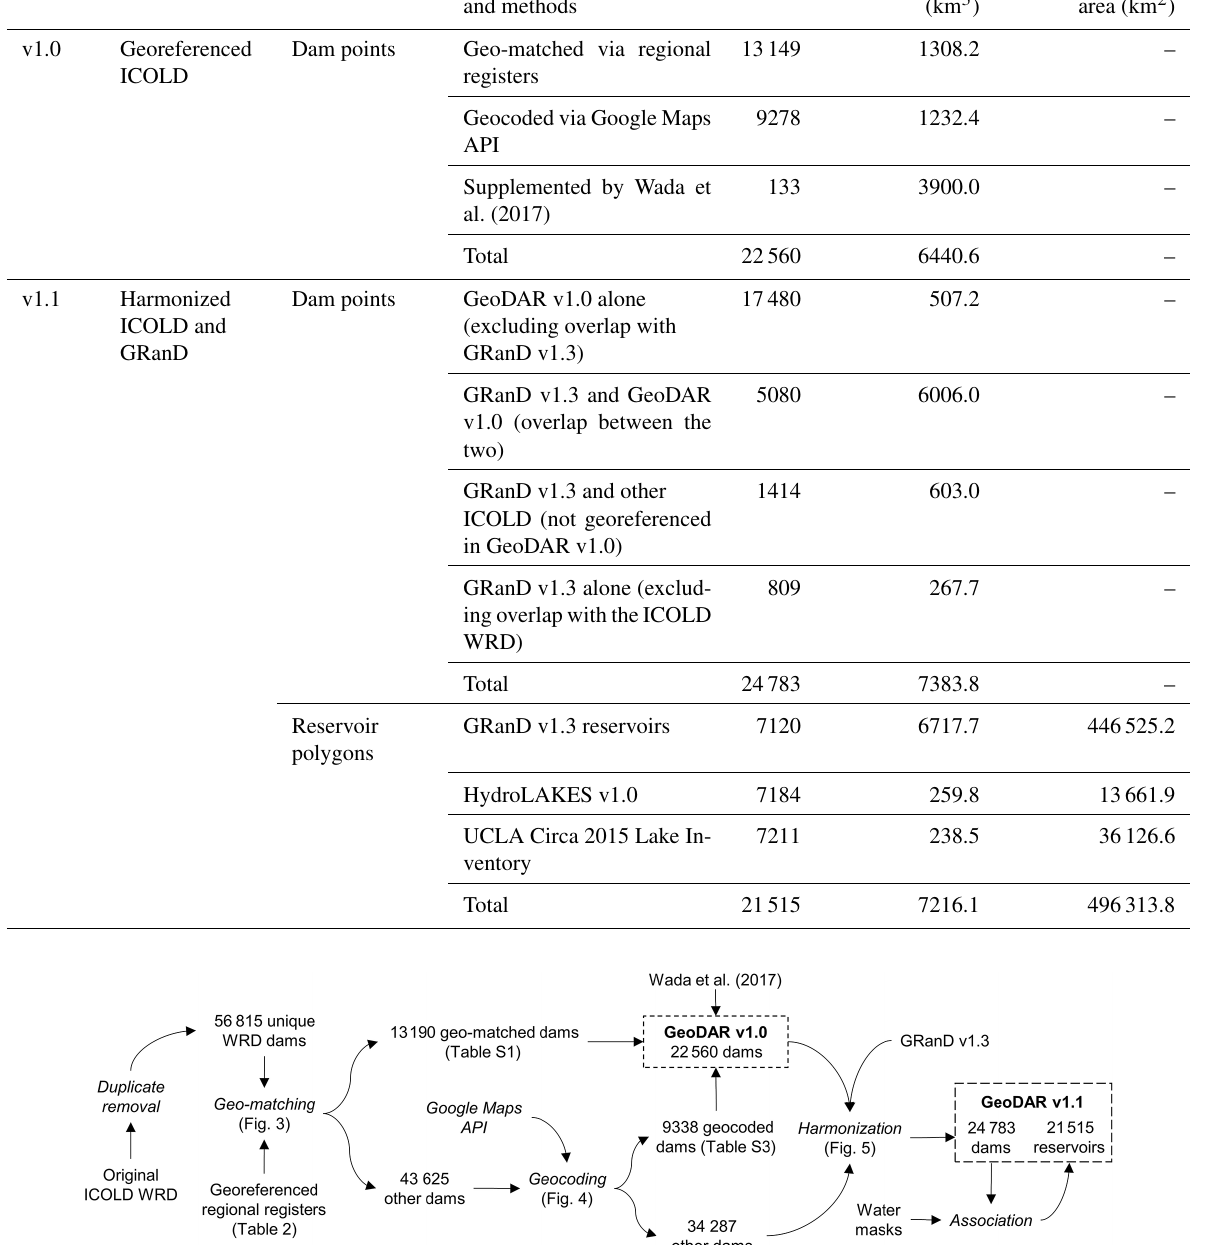
Figure 1. Schematic flowchart of GeoDAR production. Text in roman indicates applied or produced datasets, and text in italics indicates methods or